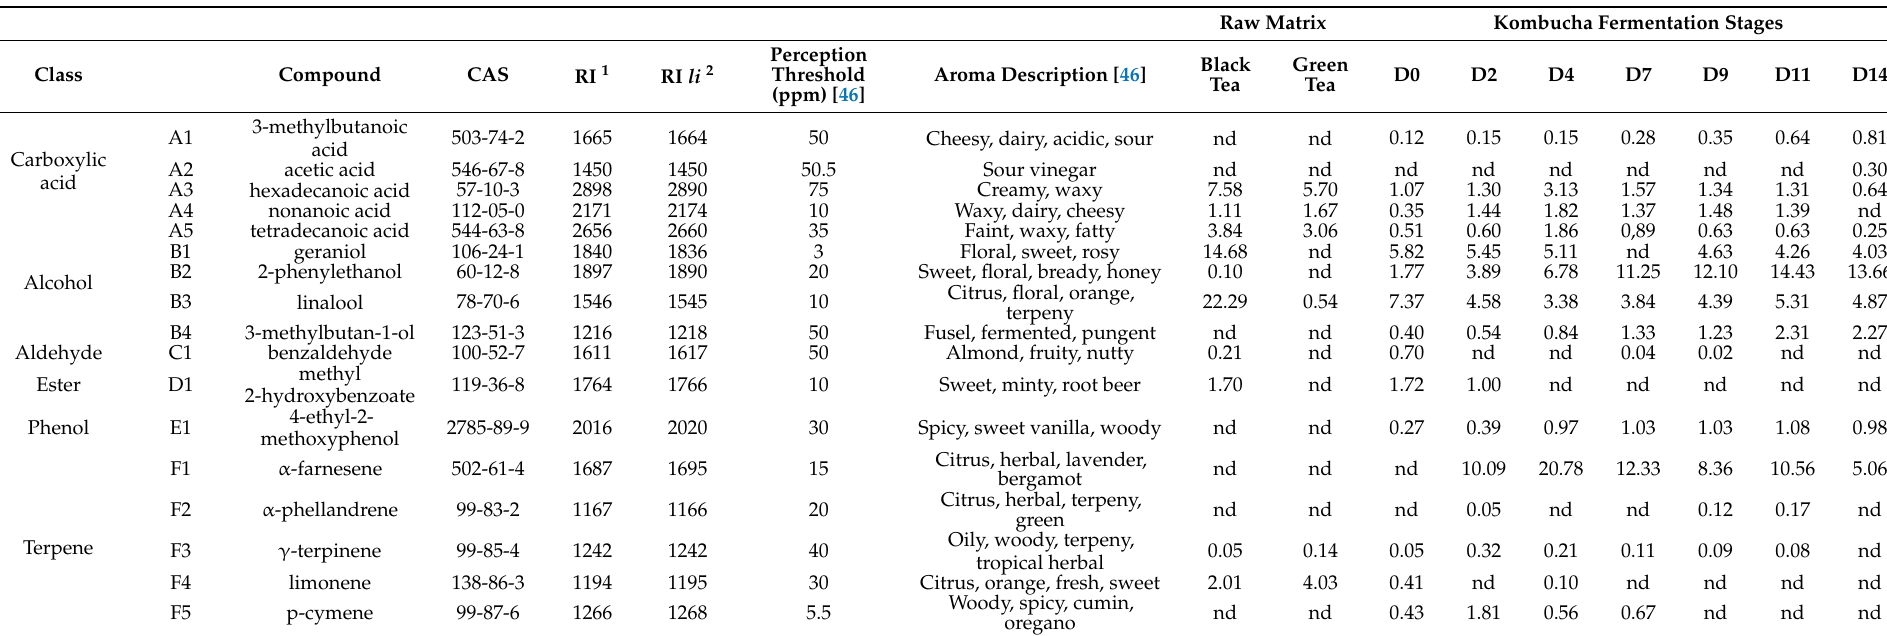
Table 2. OAV evolution of most representative volatile organic compounds (%area > 1%) with kombucha fermentation time (day) conducted at 30 ◦ C (OAV = concentration/perception